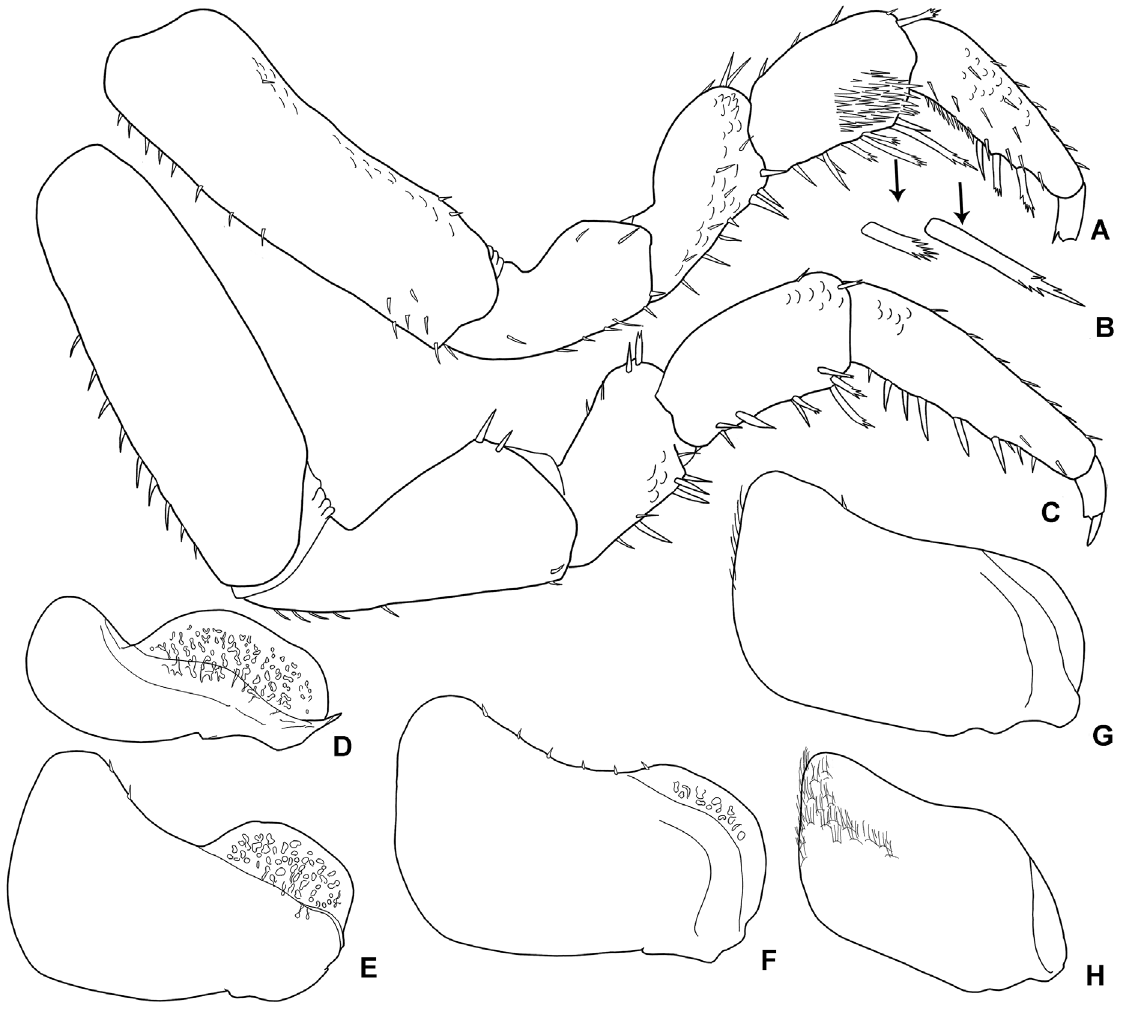
Fig. 4. Brasiloniscus verrucosus (Lemos de Castro, 1973) gen. et comb. nov., paratype, ♀ (MNRJ 6214). A . Pereopod 1. B . Pereopod 1 carpus, type of setae. C . Pereopod 7. D . Pleopod 1 exopod. E . Pleopod 2 exopod. F . Pleopod 3 exopod. G . Pleopod 4 exopod. H . Pleopod 5